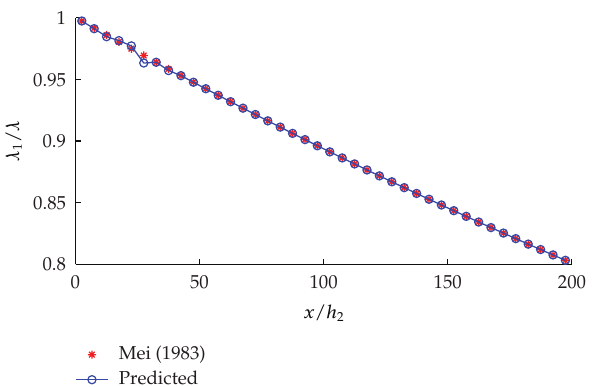
Figure 6: Theoretical and predicted amplitude wave of the soliton propagating over a discontinued bed. The point x (cid:7) 0 coincides with the discontinuous bottom